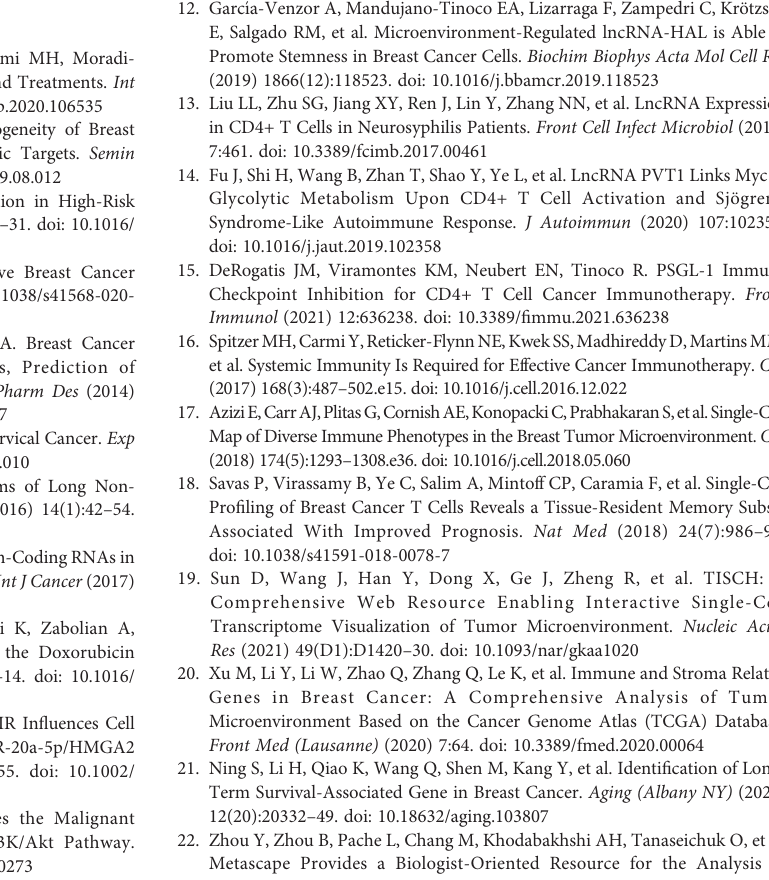
Supplementary Figure 1 | Cross-shared CD4+ Tconv-related genes in the GSE110686 and GSE114727 datasets. Supplementary Figure 2 | Identi fi cation of CD4 TLAs that were signi fi cantly different between tumor and normal groups. (A) Volcano map. (B) Heatmap. Supplementary Figure 3 | RSwasanindependentprognosticfactorinBCpatients. Univariate (A) andMultivariate (B) COXanalysis. Supplementary Figure 4 | The accuracy of the nomogram was checked with a calibration